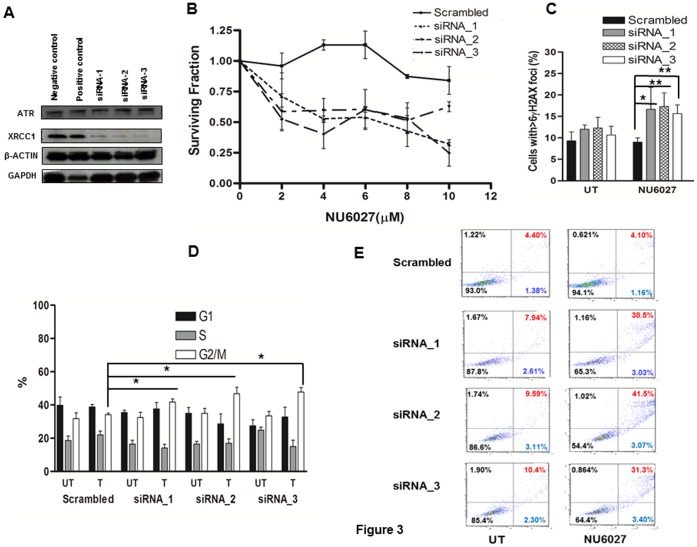
Western blot analysis in siRNA transfected OVCAR-3 cells is shown here (A).
B. Clonogenic survival assays for siRNA transfected OVCAR-3 cells treated with NU6027 at indicated concentrations is shown here (see methods for details). C. XRCC1 deficient cells accumulate significantly higher γH2AX foci compared to scrambled control cells upon NU6027 treatment. Data represent mean values ±SEM (n = 6). Results were analysed using Students t-test. * p<0.05, ** p<0.01. D. Quantification of various phases of the cell cycle is shown for siRNA transfected OVCAR-3 cell treated with NU6027 is shown here. Data represent mean values ±SEM (n = 3). Results were analysed using Students t-test. * p<0.05. E. FITC-Annexin V apoptosis assay for siRNA transfected OVCAR-3 cells is shown here. The proportion of cells in late phase apoptosis is higher in XRCC1 deficient cells treated with NU6027 compared to scrambled control cells.